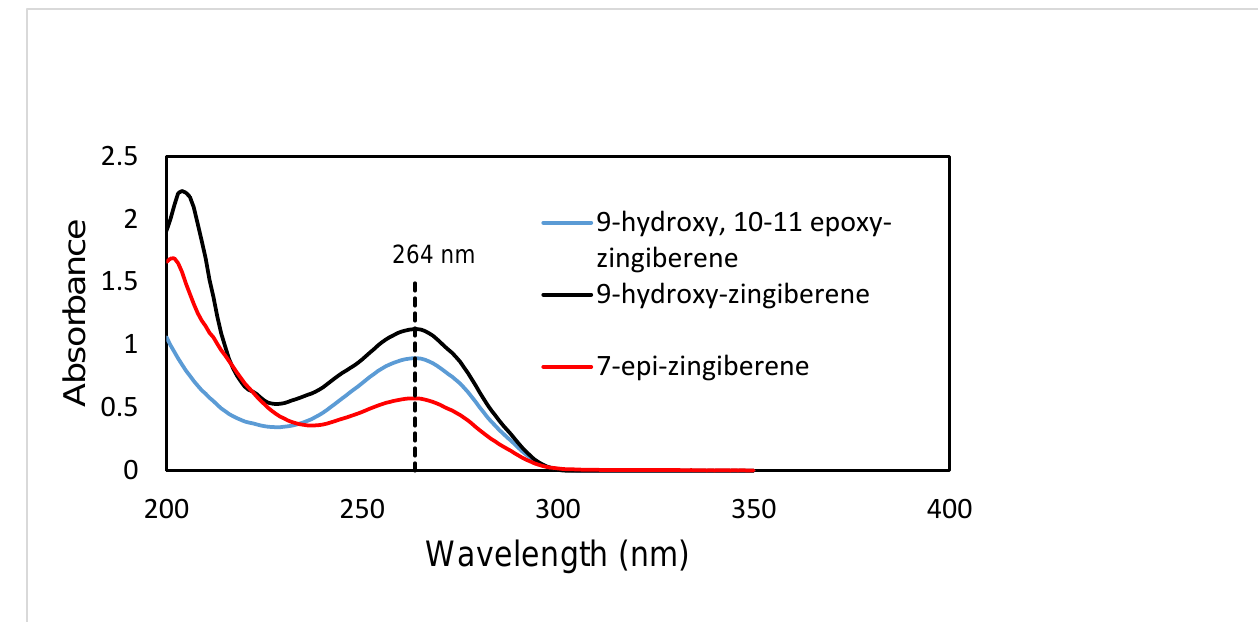
Figure 3. Example absorbance spectra for 7-epi zingiberene, 9-hydroxy zingiberene, and 9-hydroxy-10,11-epoxy zingiberene isolated by silica gel chromatography. The vertical dashed line identifies 264 nm, the λ max in the 250–280 nm region for these compounds.